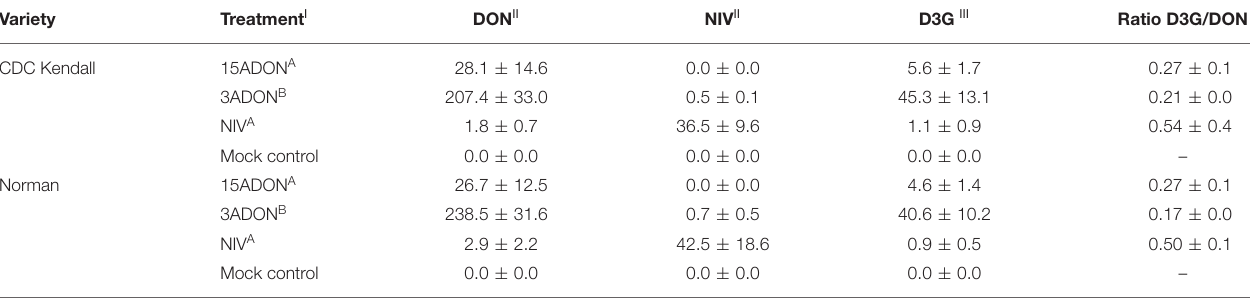
TABLE 1 | Mean ± standard error of mycotoxin content of matured barley grains for grains harvested from growth cabinet study (replication, n = 3).